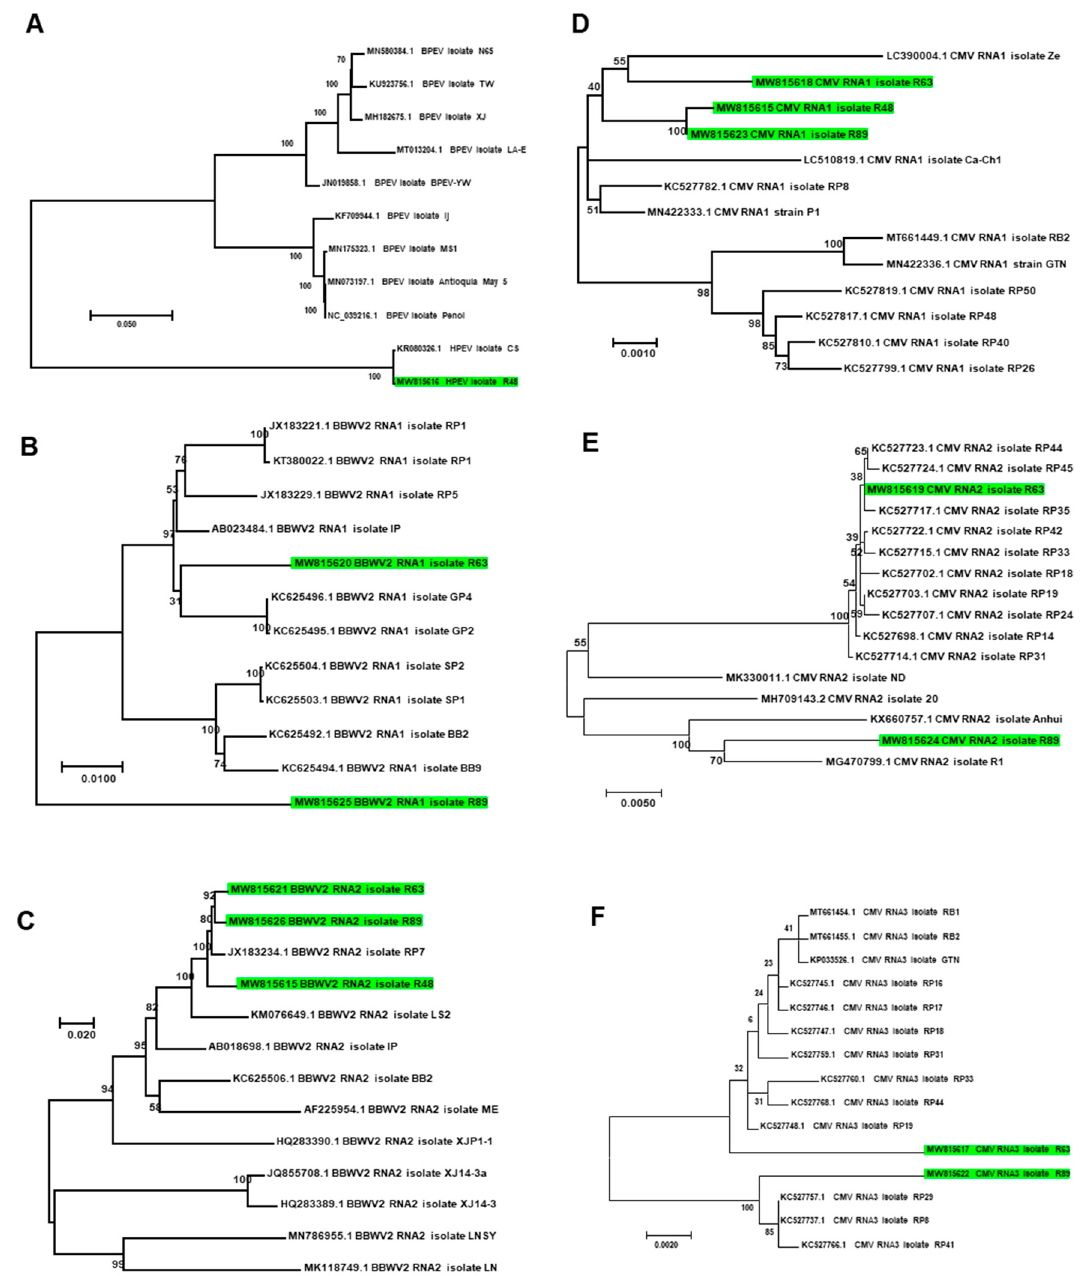
Figure 11. Phylogenetic relationships of assembled viral genomes. Phylogenetic trees for HPEV ( A ), BBWV2 RNA1 ( B ), BBWV2 RNA2 ( C ), CMV RNA1 ( D ), CMV RNA2 ( E ), and CMV RNA3 ( F ) were constructed using the maximum likelihood method using the MEGA7 program. Green colored boxes indicate viral genome fragments assembled from this study.